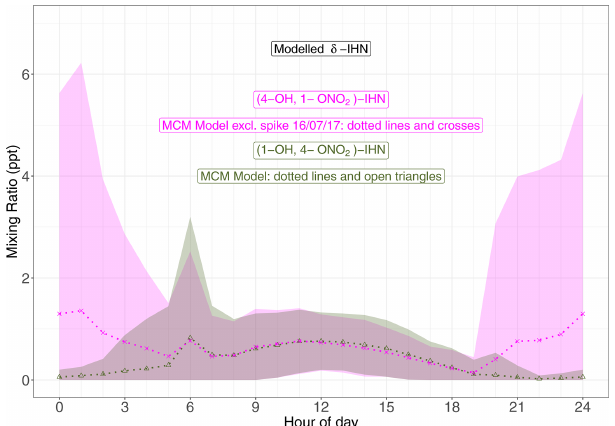
Figure 9. Diel pattern of MCM modelled δ -IHN ((1-OH, 4-ONO 2 )- IHN and (4-OH, 1-ONO 2 )-IHN). Data points are the means, and the shaded areas represent ± 1 SD in the variability of values for each hour of the